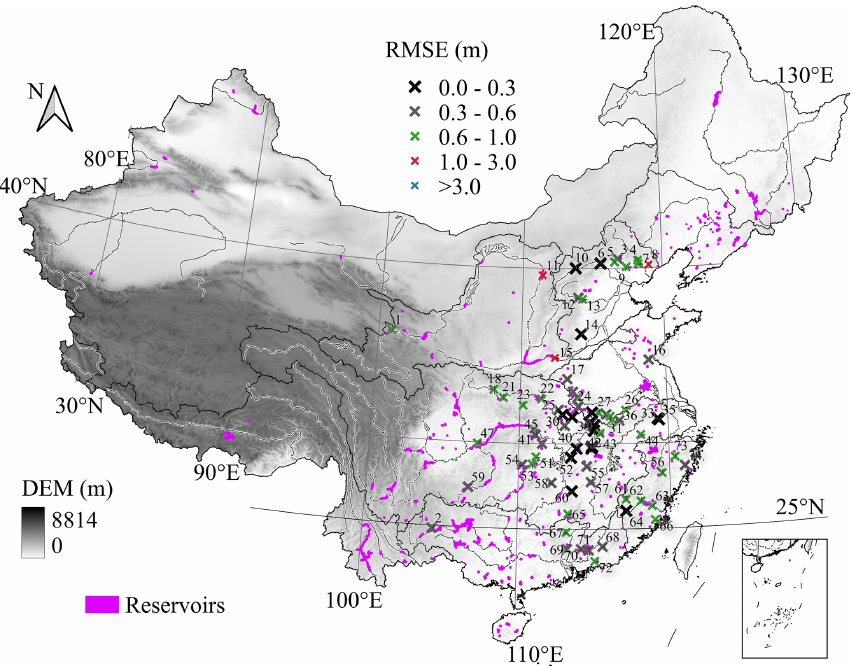
Figure 3. Performance of the enhanced-measurement products in terms of the RMSE of 74 reservoirs. For the validated reservoir ID, please refer to the